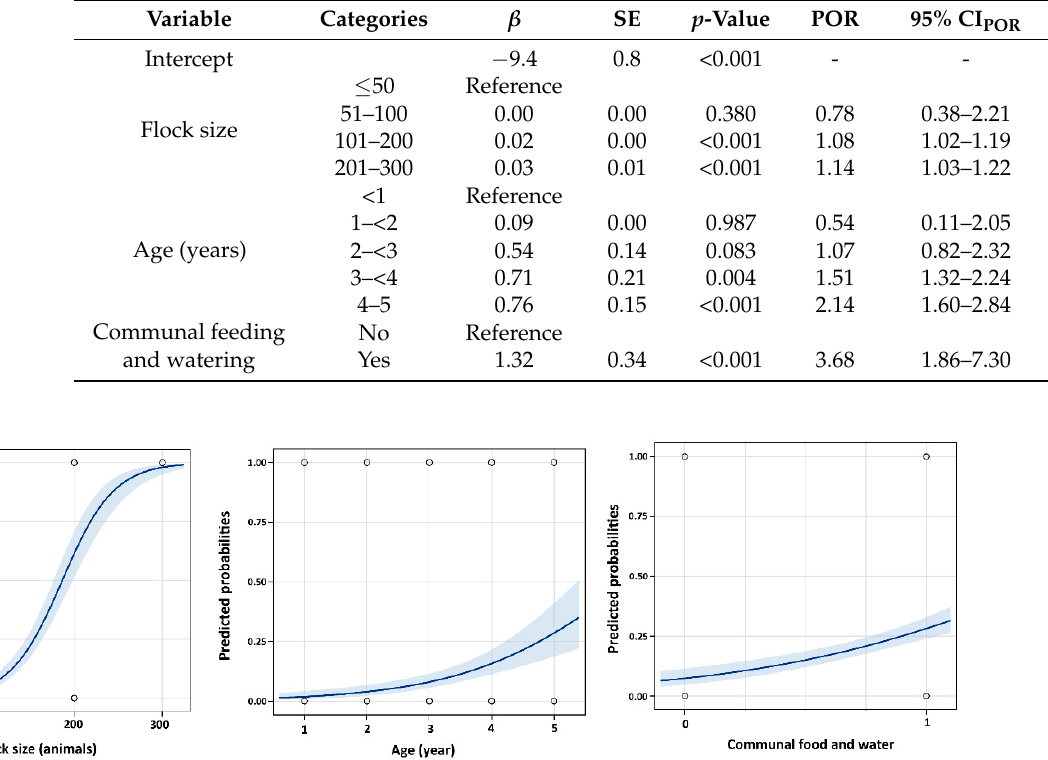
Figure 2. Probability plot for the ability of flock size, age, and communal feeding and watering categories to predict the prevalence of contagious caprine pleuropneumonia (CCPP) in the Nile Delta sheep and goats in Egypt. The curve shows the likely probability of positive CCPP associated with each large category of flock size, age, and communal feeding and watering with the 95% confidence interval shaded blue.